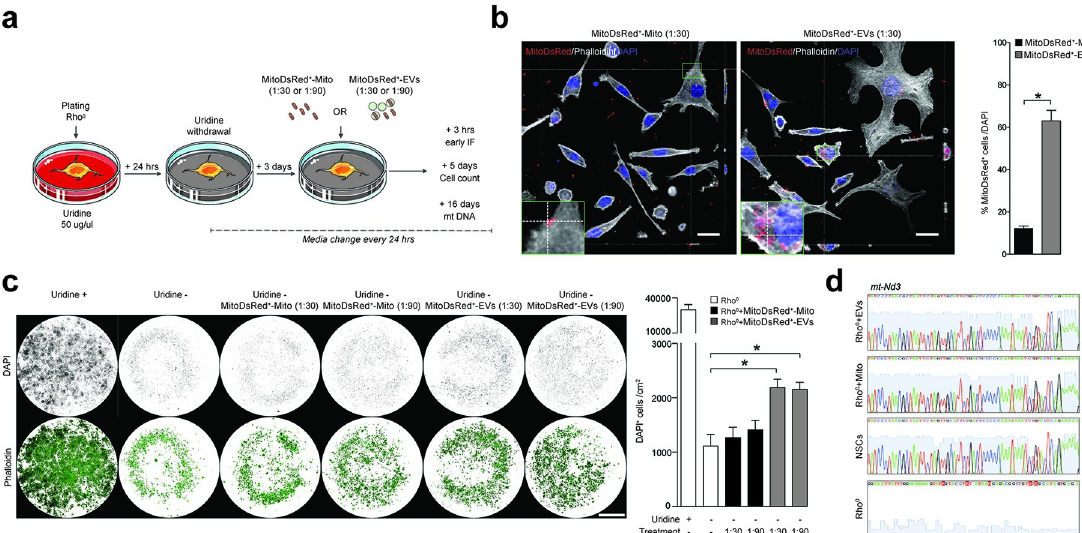
Fig 5. EV-associated mitochondria revert the auxotrophy of mtDNA-depleted cells. (a) Experimental setup for in vitro studies with L929 Rho 0 cells. L929 Rho 0 cells were deprived of uridine (Uridine − ) and then treated with either MitoDsRed + EVs (ratio 1:30 or 1:90) or MitoDsRed + Mito (ratio 1:30 or 1:90) after 3 days. (b) Representative confocal images and quantification of Uridine − L929 Rho 0 cells showing incorporation of MitoDsRed + mitochondria at 24 hours from treatment with either EVs or Mito (ratio 1:30). Orthogonal section (XY) of Z-stacks is shown. Data are mean values ( ± SEM) from Data are from N = 4 biological replicates per condition (Mann–Whitney). � p < 0.05. Scale bars: 25 μ m. (Data available in S3 Data). (c) Representative images and quantification of L929 Rho 0 cells surviving 5 days after treatment with either EVs or Mito. Data are mean values ( ± SEM) from N = 4 biological replicates per condition. � p � 0.05 (One- Way ANOVA, followed by Mann–Whitney). Scale bars: 3.25 mm. (Data available in S3 Data). (d) Sanger sequencing chromatograms showing the mitochondrial encoded gene mt-ND3 in L929 Rho 0 cells at 16 days after treatment with either EVs or Mito. NSCs and L929 Rho 0 cells are used as positive and negative controls, respectively. EV, extracellular vesicle; mt-ND1, mitochondrial gene NADH dehydrogenase subunit